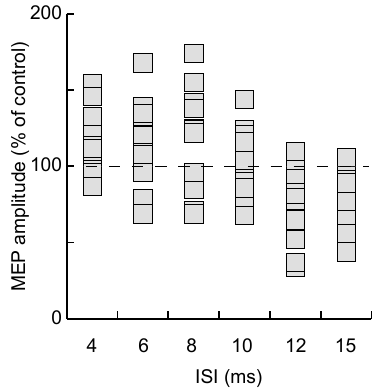
Figure 3. Individual participants’ MEP amplitudes at the different ISIs. MEP amplitude is expressed as the percentage of the control condition (s-pulse). The dashed horizontal line represents 100% (i.e., when the p -pulse condition equals the s-pulse condition). Each rectangle represents the mean MEP amplitude across trials in each participant. Table 1. Mean values and standard error of the MEP amplitude in the different TMS conditions.